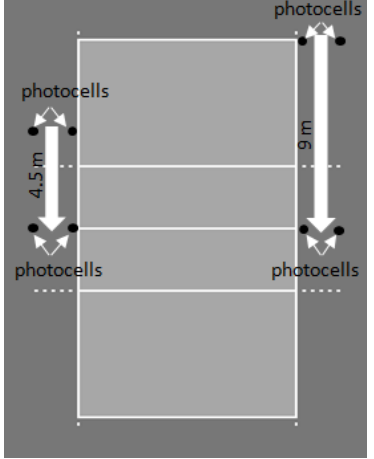
Figure 3. Sprint tests procedure.